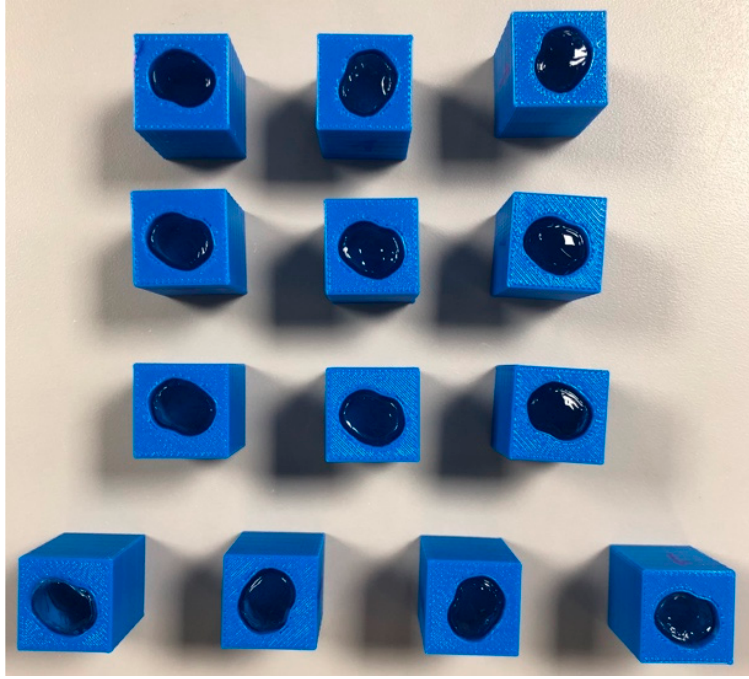
Figure 4. 3D printed molds for casting enlarged extruded Ottawa #20-30 particles. Note Hydrogel modelled particles cast in the molds.